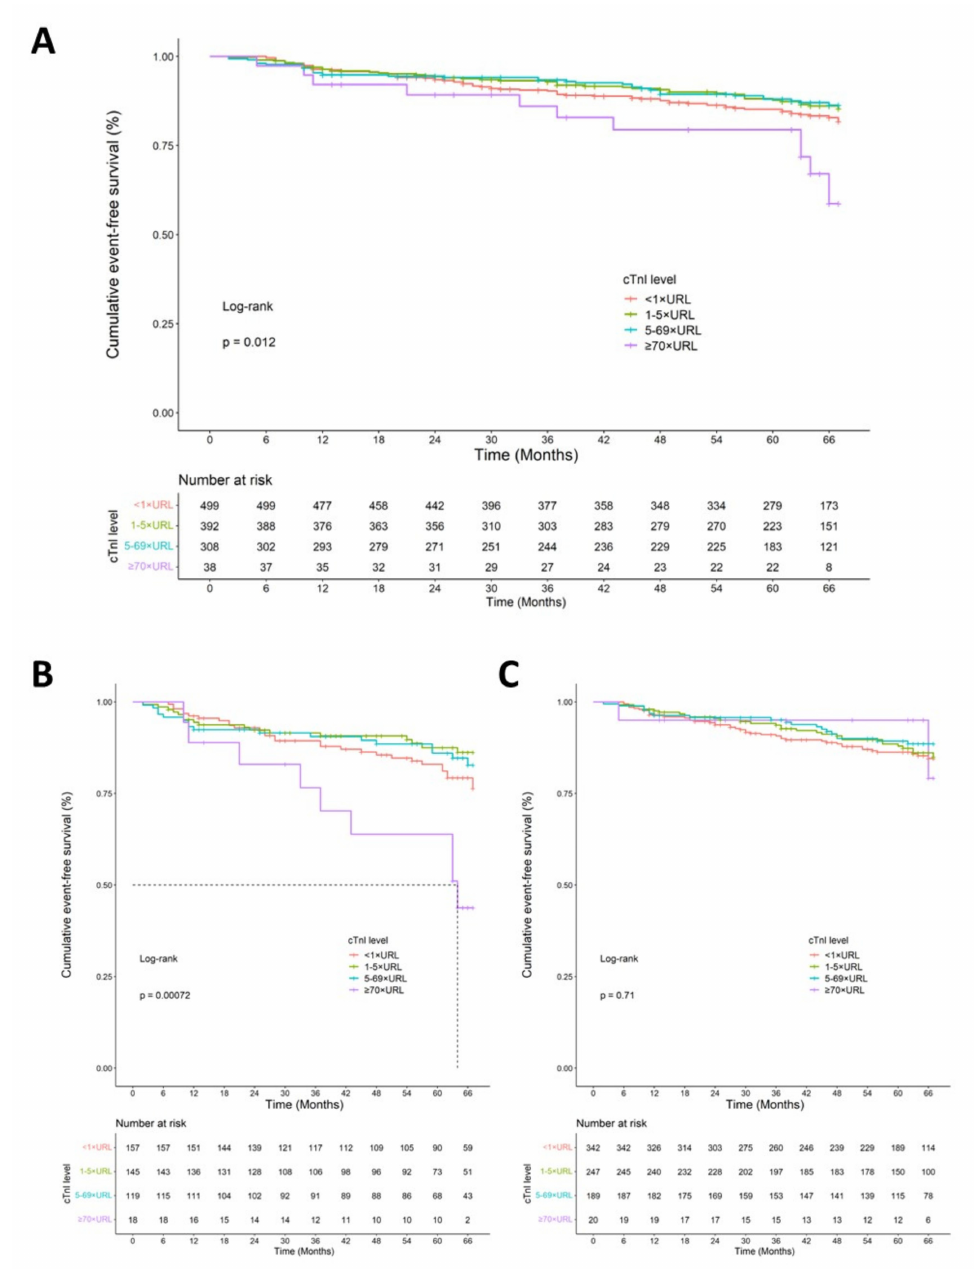
Figure 1. Cumulative Kaplan–Meier survival curve analysis of 5-year MACEs in total patients ( A ), TVD patients ( B ), and non-TVD patients ( C ) according to postprocedural cTnI levels. Notes: MACEs, major adverse cardiovascular events; cTnI, cardiac troponin I; URL, upper reference limit; TVD, three-vessel disease; non-TVD, non-three-vessel disease, including single-vessel disease and double-vessel